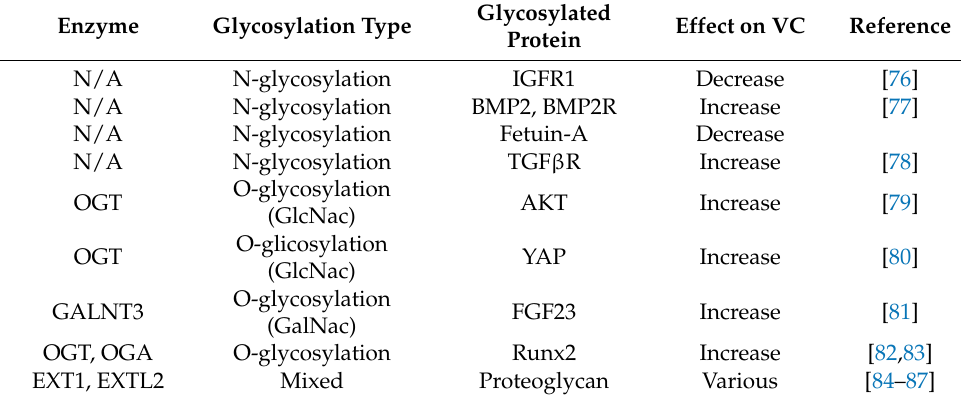
Table 1. Glycosylation of proteins related to vascular